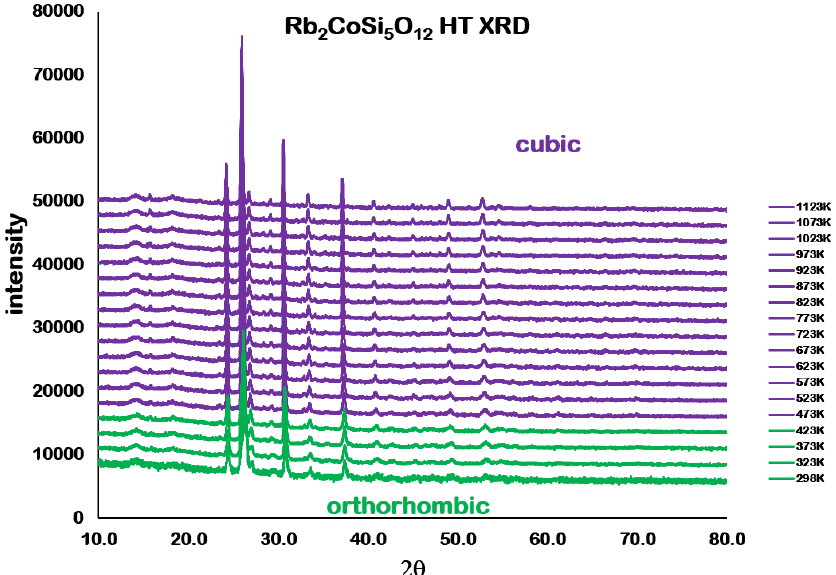
Figure 3. Plot showing XRD data for Rb 2 CoSi 5 O l2 10–80 ◦ 2 θ over the temperature range 298–1123 K. Pbca orthorhombic data are shown in green and Pa 3 cubic are shown in purple.